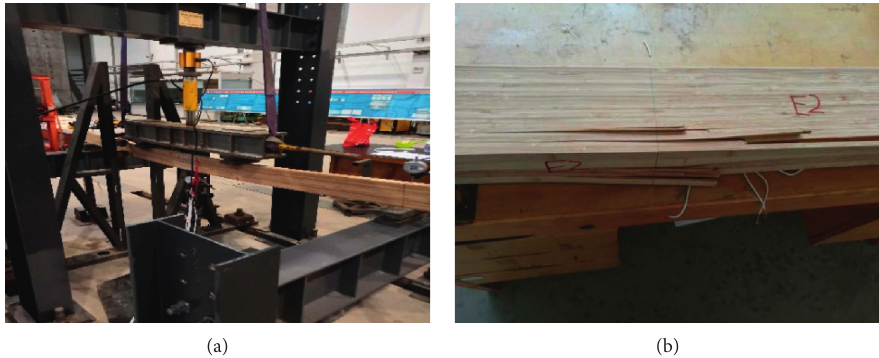
Figure 11: Failure mode of bending beam. (a) Groups A and B. (b) Group C and D.